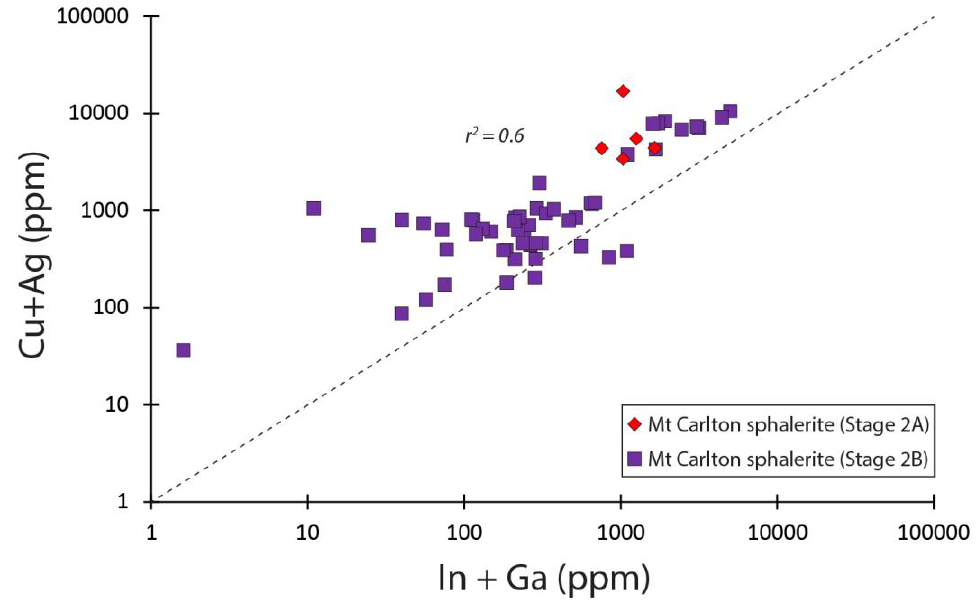
Figure 7. Correlation plot of Cu + Ag vs. In + Ga in Mt Carlton sphalerite, based on LA-ICP-MS spot data.